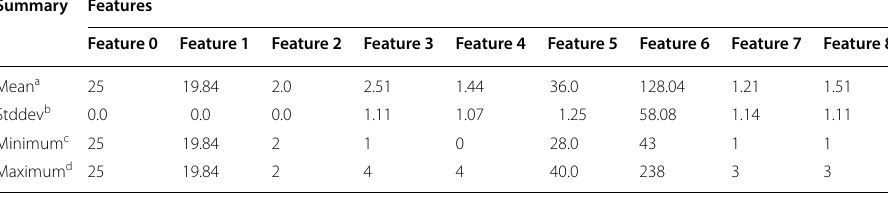
a The average of all values of features b The amount of variation or dispersion of the set of data values c The minimum of all features d The maximum of all features